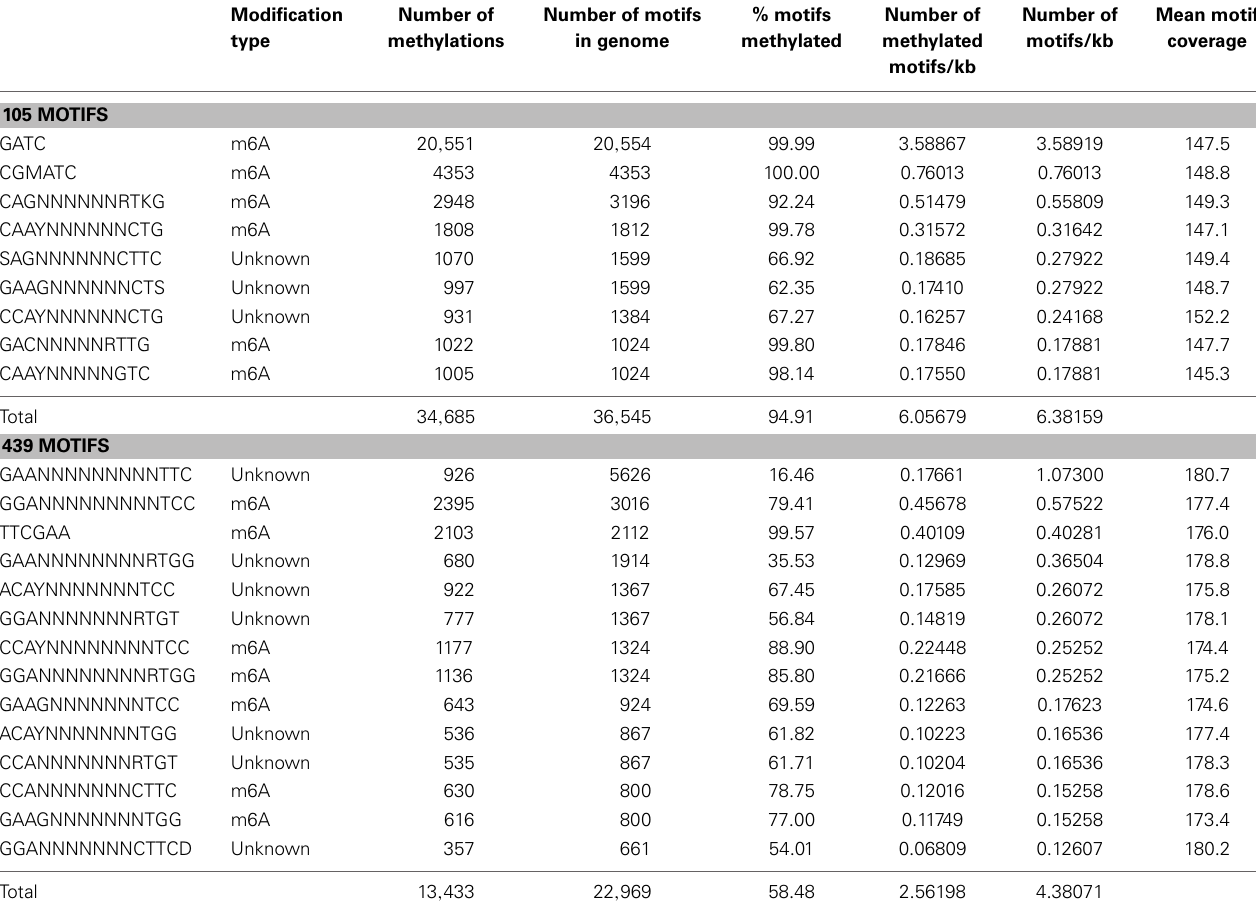
Table 3 | Methylated motif analysis of the 105 and 439